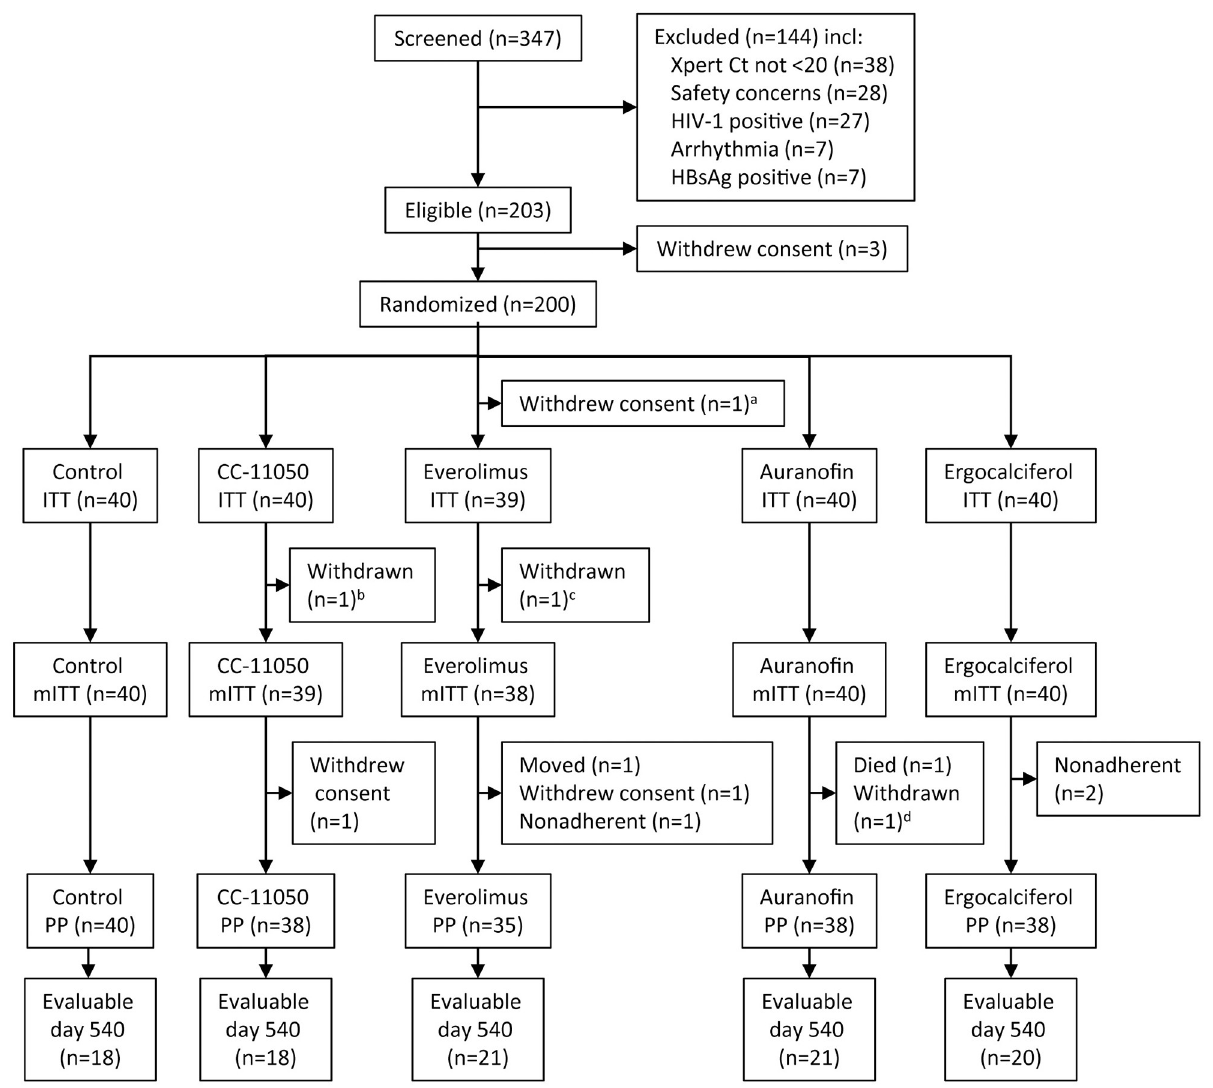
Fig 1. CONSORT diagram. a Withdrew consent prior to receiving any treatment. b Found to have spinal tuberculosis on baseline PET/CT scan. c Found to have elevated blood glucose at screening. d Required an excluded concomitant medication. ITT = intent to treat; PP = per protocol; Ct = cycle threshold. From